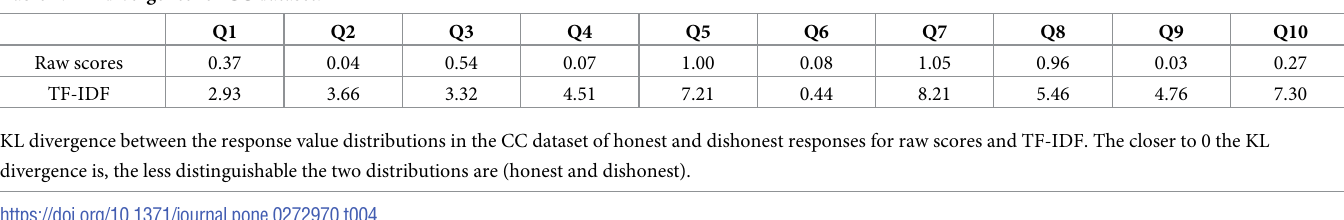
Table 4. KL divergence for CC